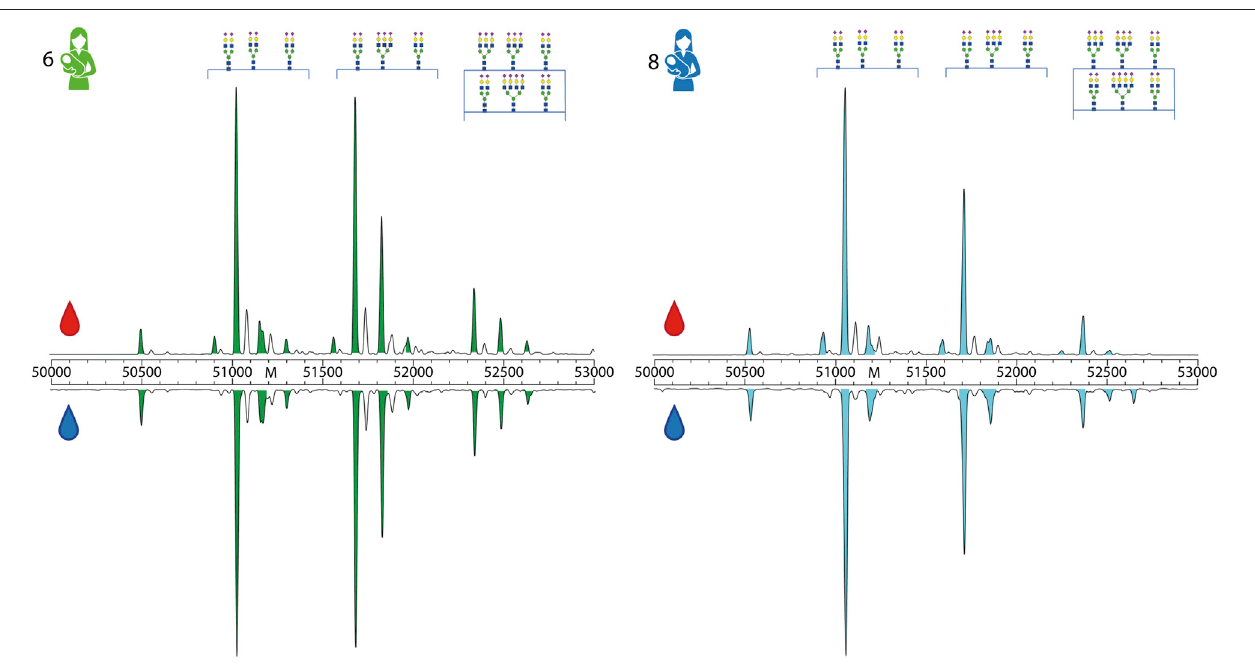
FIGURE 4 | Direct comparison of proteoform pro fi les from donor 6 and 8. Depicted here are the zero-charge deconvoluted spectra of A1AT derived from serum (top, red droplet) and milk (bottom, blue droplet), in the mass range of 50,000 – 53,000 Da. Donors and peaks are color-coded as in Figure 1 . The main peaks are annotated by their glycan composition, fully annotated proteoform pro fi les of these donors can be found in Supplementary Figures S7, S9 . When comparing the abundancesofdifferentproteoforms betweendonor6and 8,itisclear thateachpro fi leisdifferent.Forexample,donor6hasahigher abundanceofbranchedand fucocylated A1AT than donor 8. An overview of all measured proteoform pro fi les of all donors and all samples are given in the related Supplementary Figures S2 – S9 .